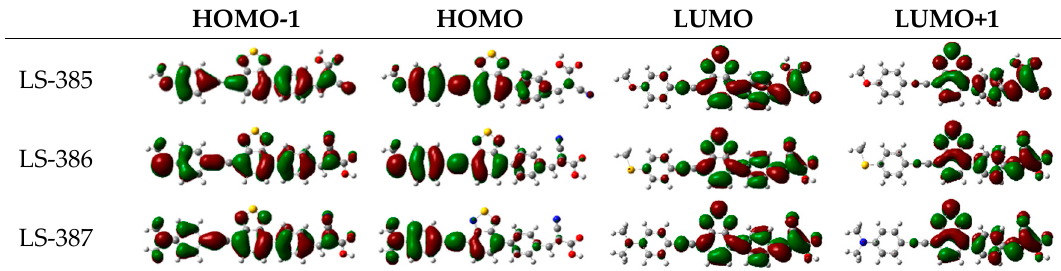
Figure 2. Frontier molecular orbital of LS-385, LS-386, and LS-387 calculated under B3LYP/6–31G(d) level.